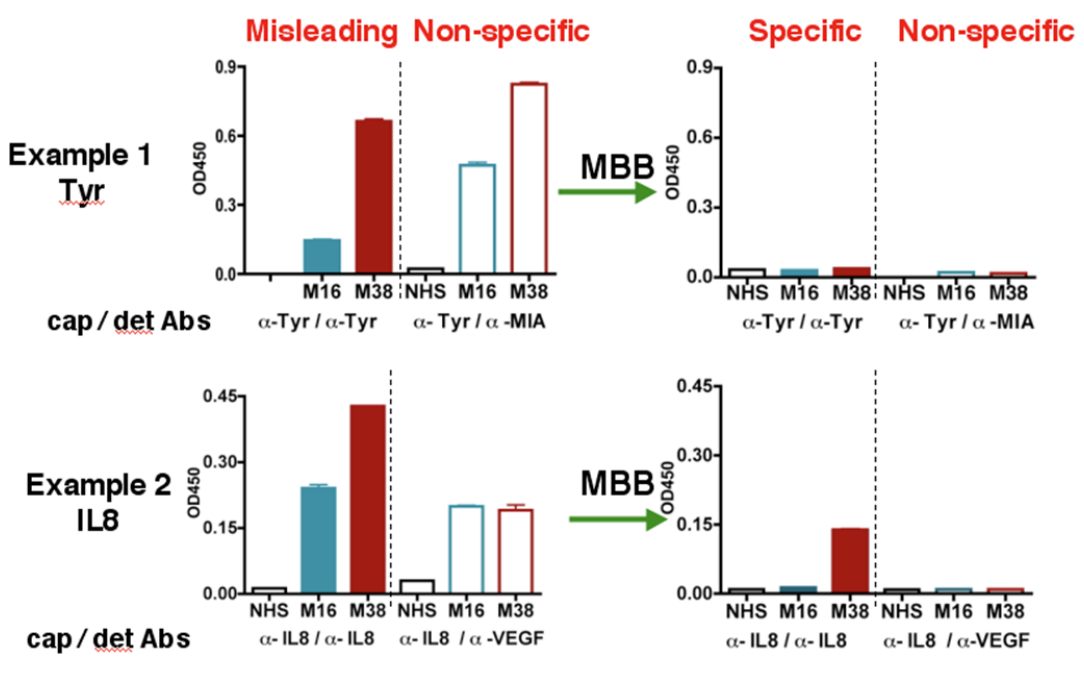
Figure 1. MBB reduces non-specific bindings in the ELISA assay. Serum samples NHS, M16, and M38 were diluted in either 1% BSA (left) or MBB buffer (right) for ELISA assay. For Tyrosinase (Tyr), antibody T9230 (US Biologicals) and biotinylated T311 were used as the capture antibody and the detection antibody, respectively. For IL-8, the IL-8 Cytoset from Biosource was used. To show non-specific bindings, Tyr or IL-8 capture antibodies were used but biotinylated anti-MIA or anti-VEGF antibodies were used respectively as the detection